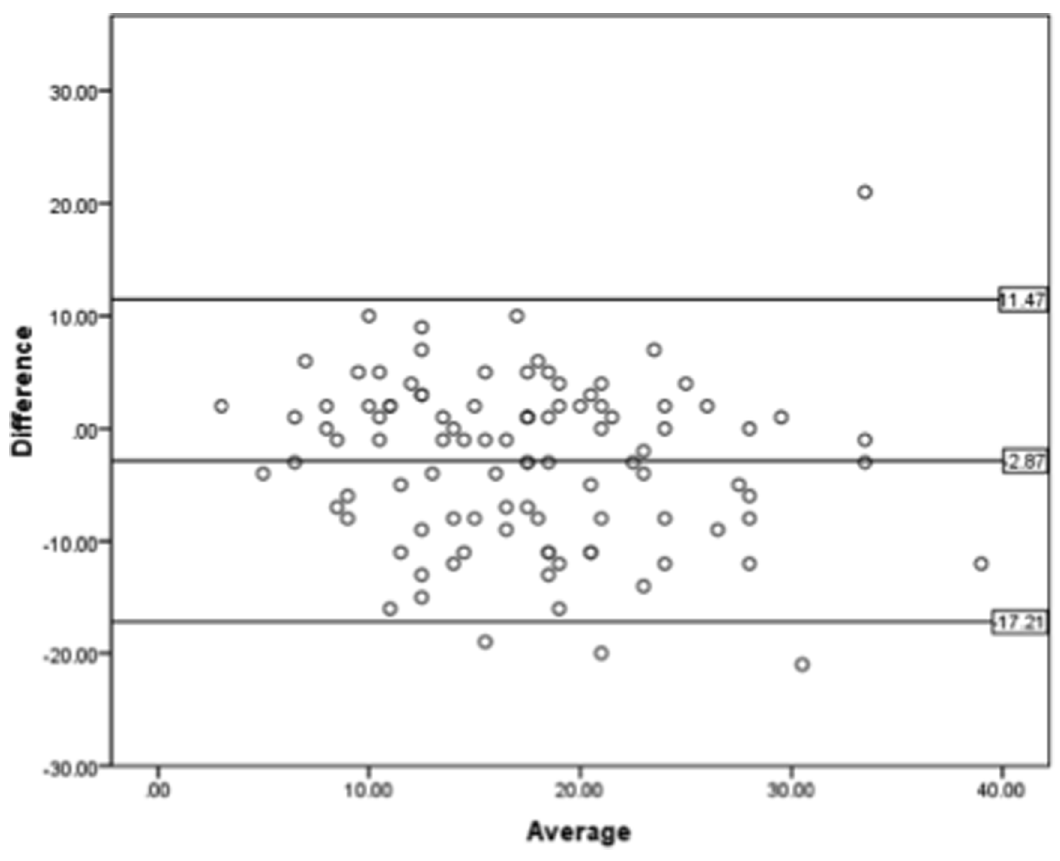
Figure 3. Agreement between PCWP and LEDP in the entire study population. Bland-Altman plot of PCWP and LVEDP pairs for all 101 patients included in the study. Difference indicates difference between PCWP and LVEDP pairs (in mmHg), with positive values indicating that PCWP is higher than corresponding LVEDP for that particular patient, and with negative values indicating that PCWP is lower. Average indicates value of corresponding PCWP and LVEDP pairs divided by 2 ([PCWP + LVEDP/2]). Upper and lower horizontal lines indicate upper and lower borders of 95% limits of agreement, respectively; horizontal line in middle represents mean bias.